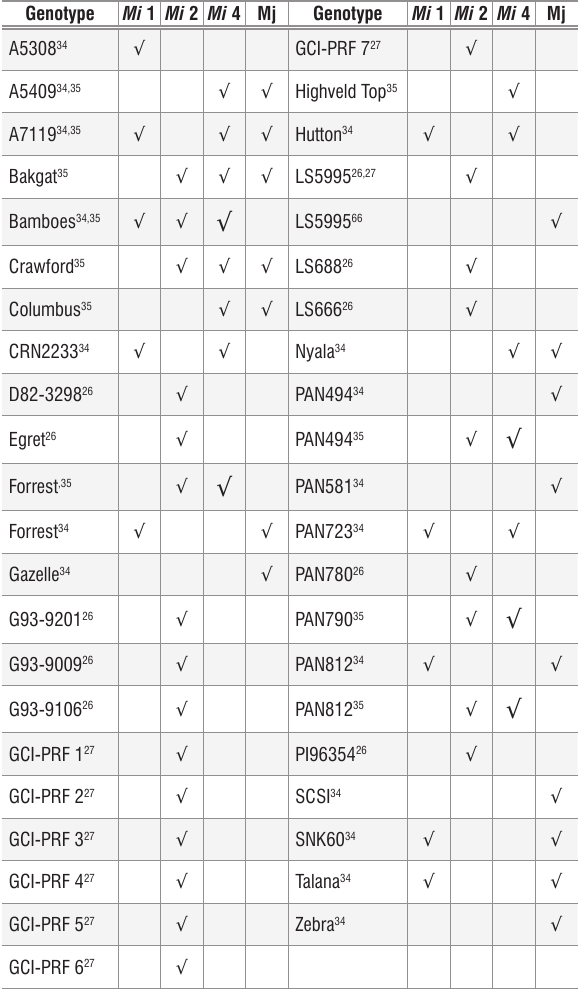
Soybean genotypes resistant to various South African root-knot nematode species and races 26,27,34,35,66